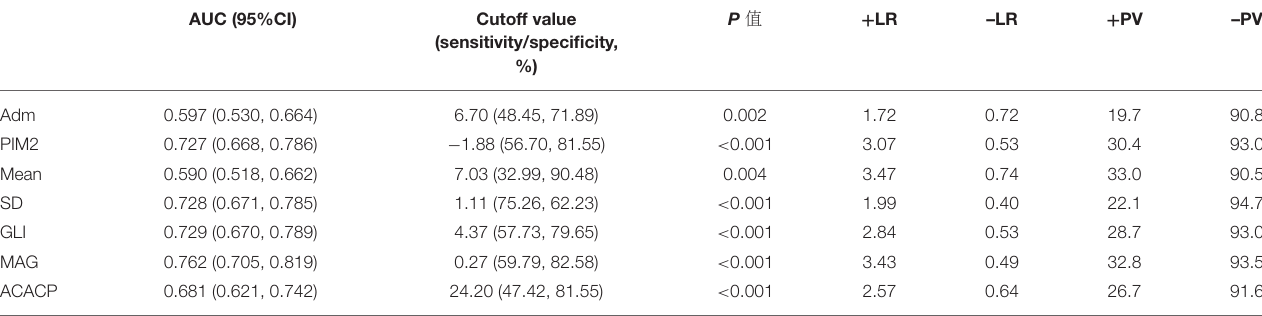
TABLE 3 | Receiver operating characteristic curves for mortality on critically ill children.